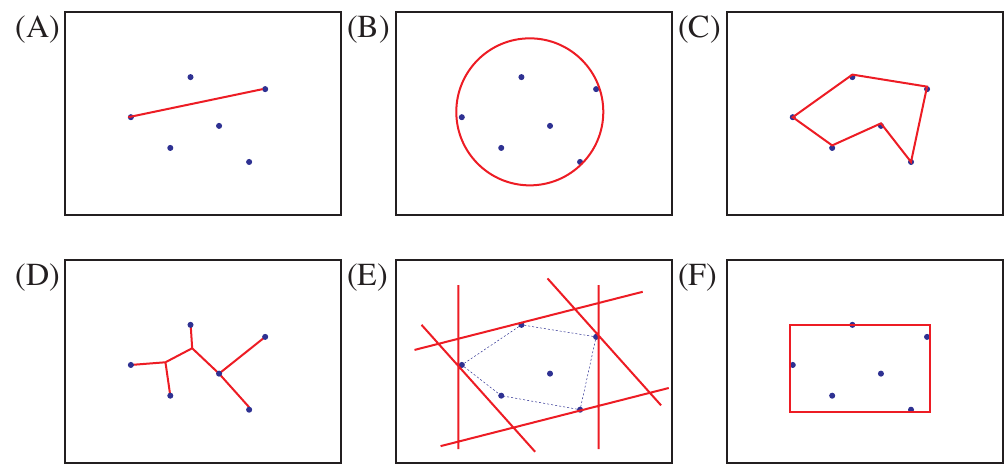
Figure 1: Six examples of diversities. Points indicate a finite subset A of R n . The diameter diversity (A) equals the maximum distance between points in A ; The ball diversity (B) equals the diameter of the smallest ball enclosing A ; The TSP diversity (C) equals half the length of the shortest tour through A ; The Steiner diversity (D) equals the length of a minimal Steiner tree for A ; The mean width diversity equals the scaled mean width of the convex closure of A ; The L 1 diversity (E) equals the sum of the dimensions of the smallest axis-aligned box enclosing A